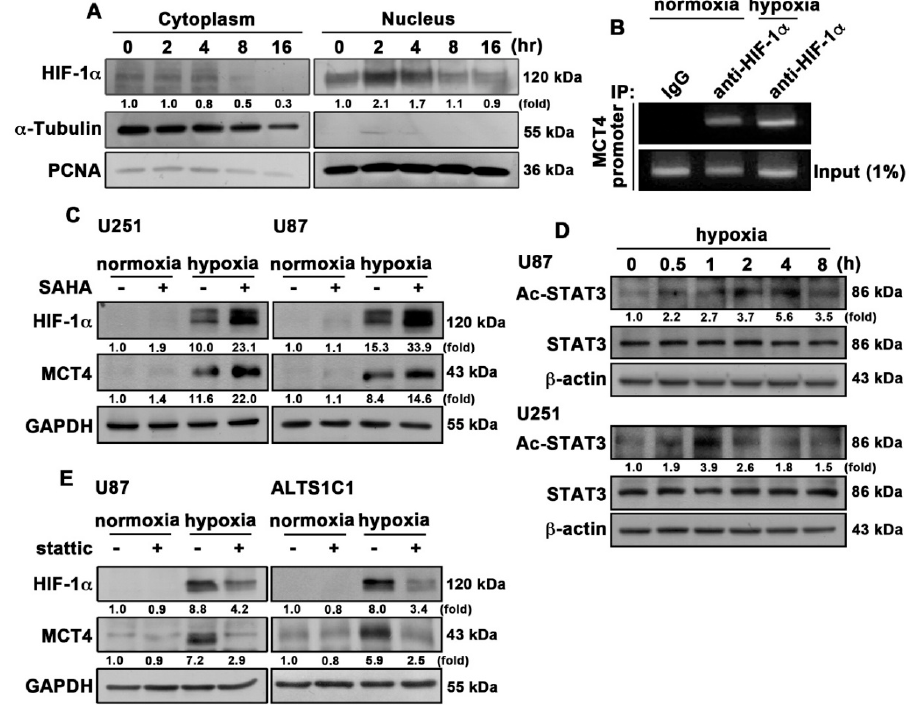
Figure 6. Acetylated STAT3 is involved in hypoxia-induced HIF-1 α and MCT4 expressions in GBM. ( A ) The cytosolic and nuclear extracts from hypoxia-induced (1% O 2 ; 2, 4, 8 or 16 h) U251 cells were subjected to western blotting. Levels of HIF-1 α were determined. ( B ) U87 was exposed to hypoxic conditions (1% O 2 ) for 4 h, and cells were then fixed and subjected to chromatin immunoprecipitation assayusingantibodiesagainstHIF-1 α ormouseIgG.Levelsofimmunoprecipitatedchromatinfragments of the MCT4 promoter or input were examined by PCR. ( C ) U251 (left panel) and U87 (right panel) cells were treated with SAHA (HDAC inhibitor; 2 µ M) for 30 min and were exposed to hypoxic conditions (1% O 2 ) for 24 h. HIF-1 α and MCT4 expression levels were determined using western blotting. ( D ) U87 and U251 cells were exposed to hypoxic conditions (1% O 2 ) for indicated time periods (0.5, 1, 2, 4 or 8 h), and acetylated-STAT3 expression was determined using western blotting. ( E ) U87 (left panel) and ALTS1C1 (right panel) cells were treated with stattic (STAT3 inhibitor; 10 µ M) for 30 min and